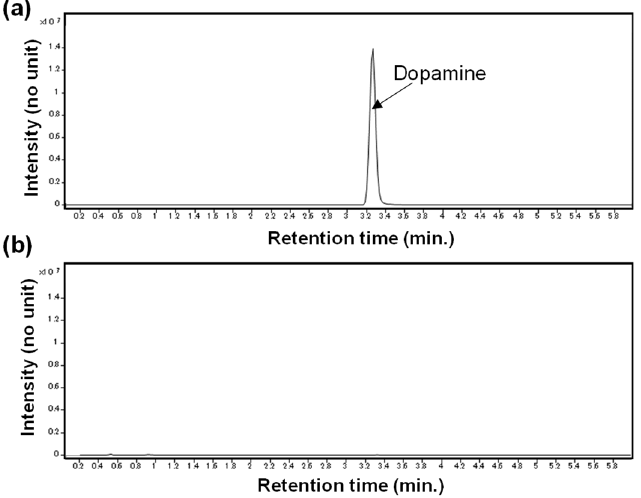
Figure A8. Representative extracted ion chromatographs of dopamine ( m / z = 154.0863, positive mode). ( A ) Standard mixture. ( B ) Urinary sample.